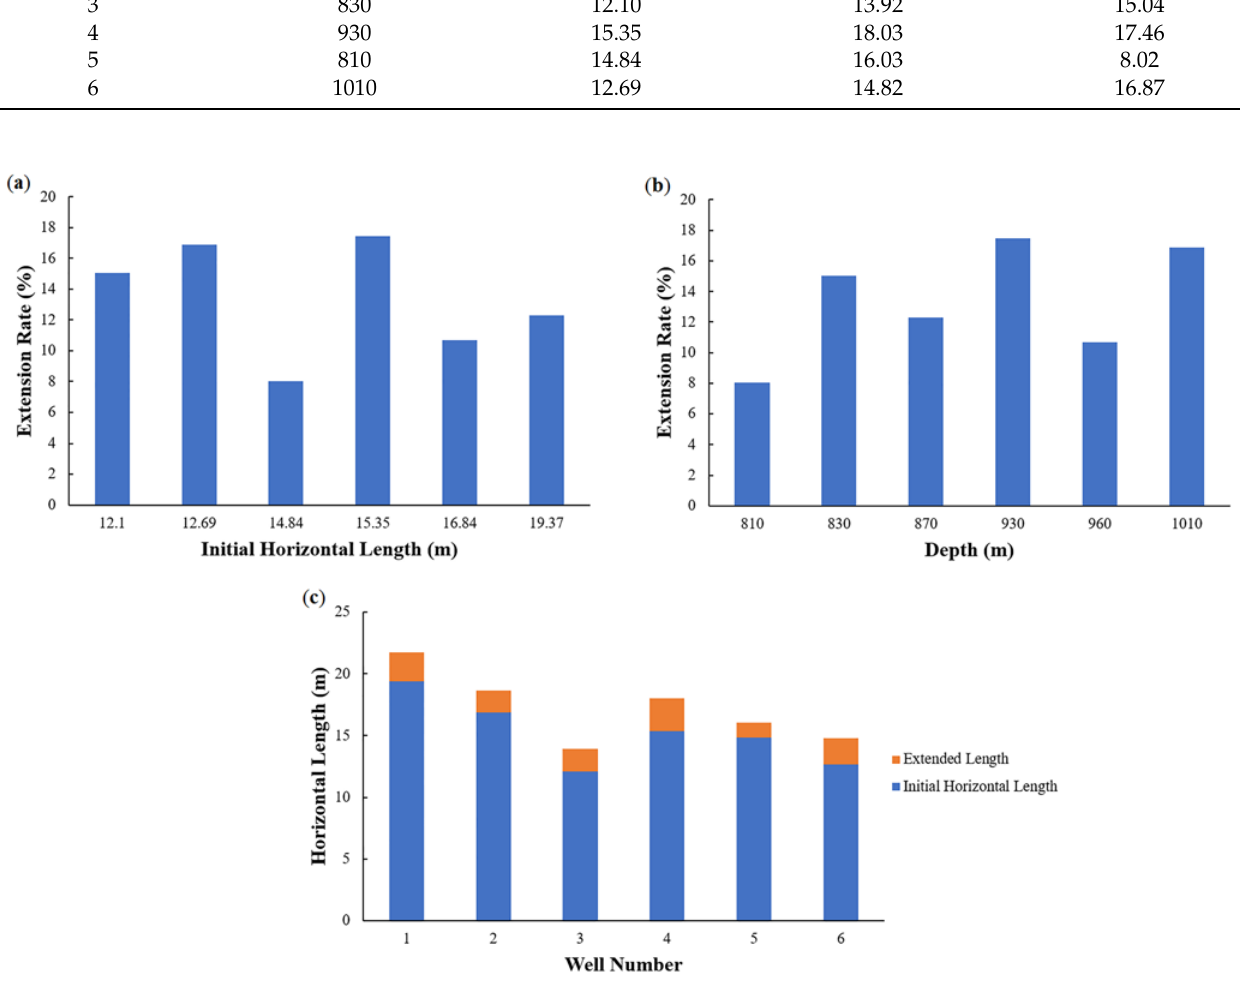
Figure 15. Results for DFDR-based field trials. ( a ) Extension Rate vs. Initial Horizontal Length; ( b ) Extension Rate vs. Depth; ( c ) extended length of each URHW.